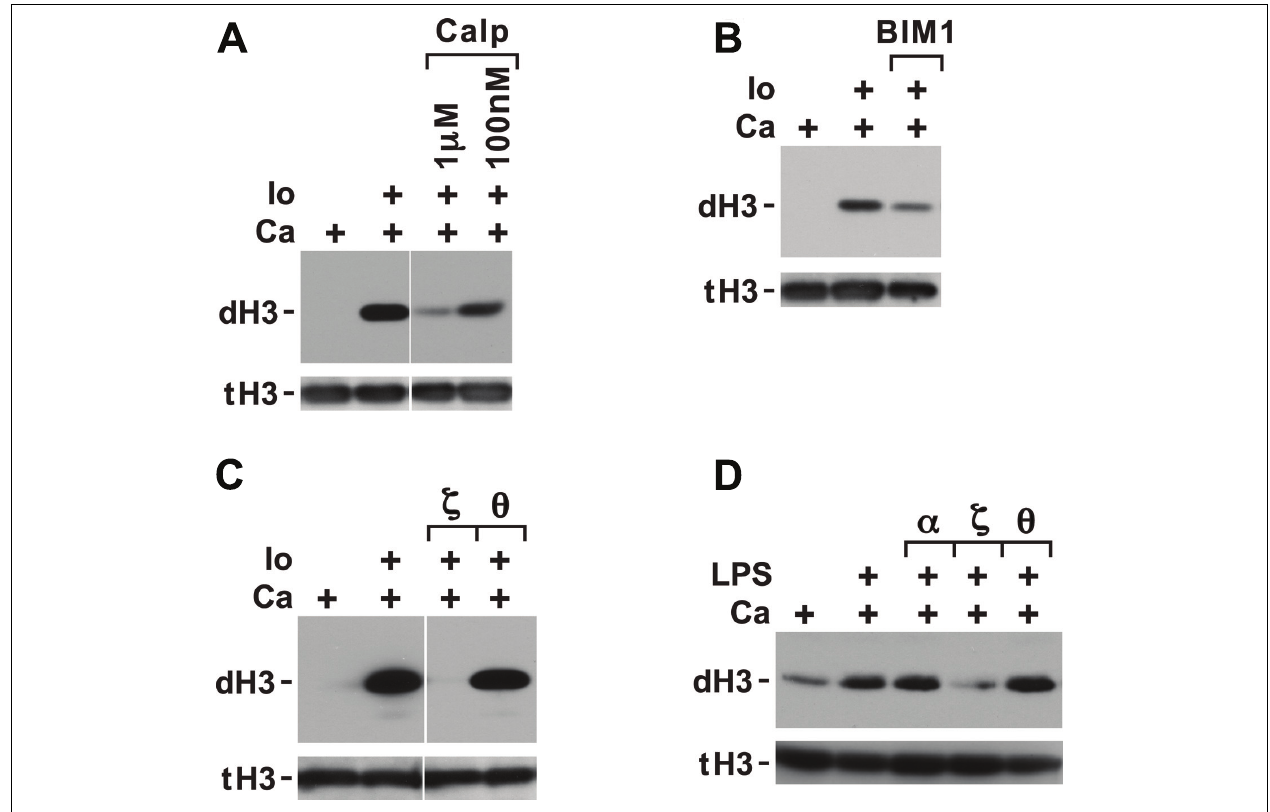
by a peptide inhibitor of PKC ζ but not by an inhibitor of PKC τ (C) .The vertical white lines separate lanes from the same gel that were taken with identical autoradiographic exposure but were arranged differently in the original gel. The presence of stimuli is indicated by a plus sign. Addition of LPS in PBS (100 ng/ml) enhanced histone deimination, and a peptide inhibitor of PKC ζ but not of PKC τ or α / β suppressed the elevated level of deimination (D) .